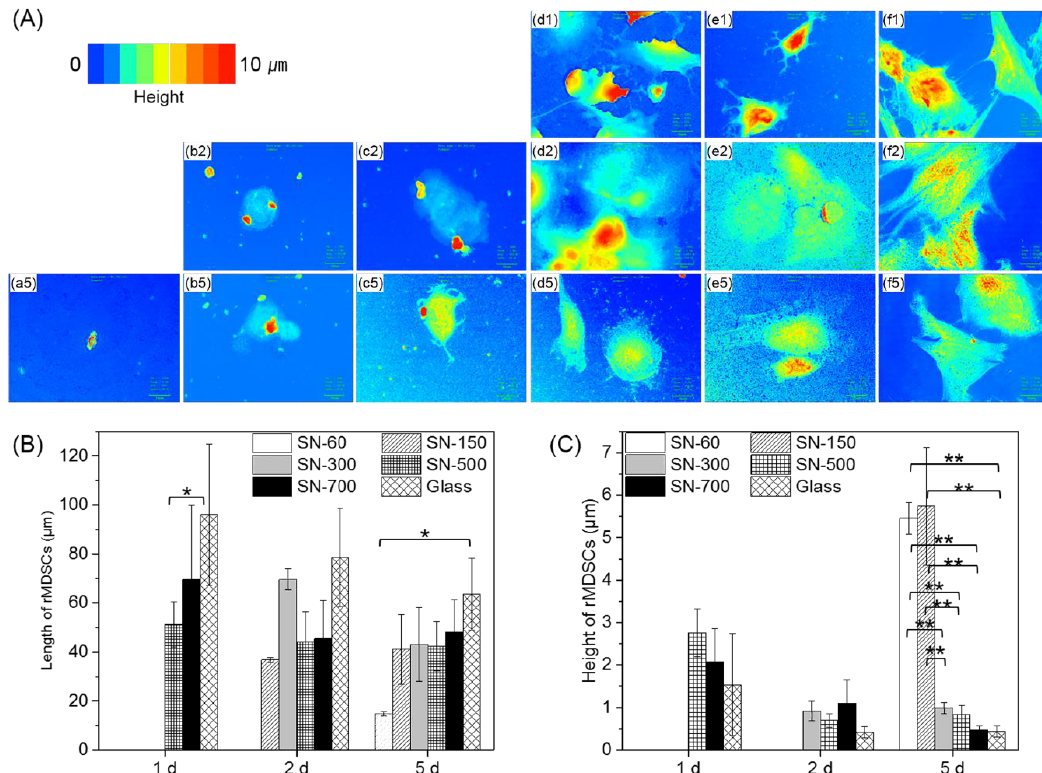
Figure 4. Confocal microscopic analysis of the length and height of rMDSCs grown on different